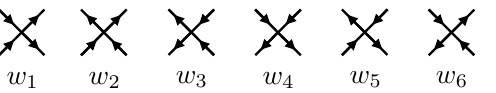
Figure 4: Vertices of the 6-vertex